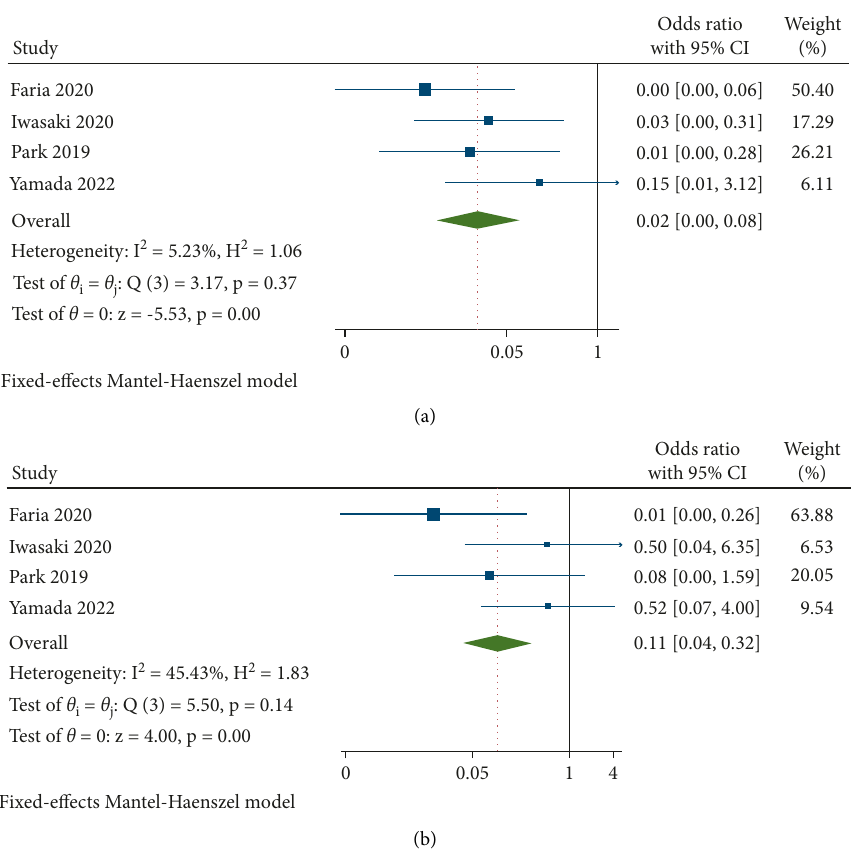
Figure 4: Forest plot of secondary outcomes of ILM flap covering technique versus ILM flap filling technique. (a) ELM reconnection rate. (b) EZ restoration